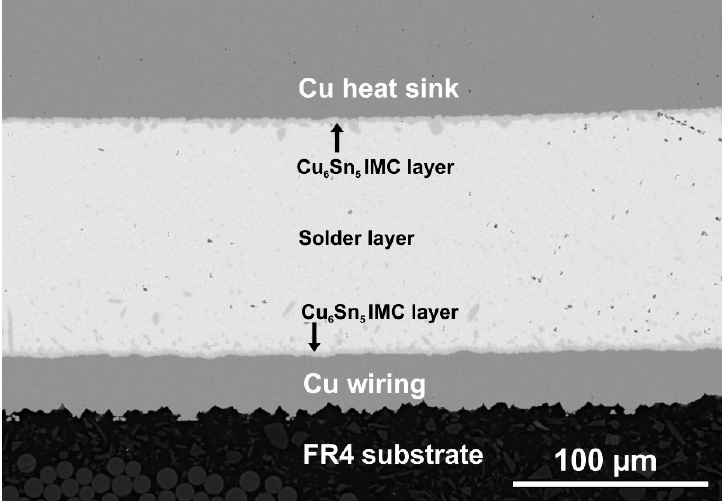
Figure 9. An exemplary “sandwich structure” of the solder joints under IGBT soldered in batch oven (SEM micrograph).